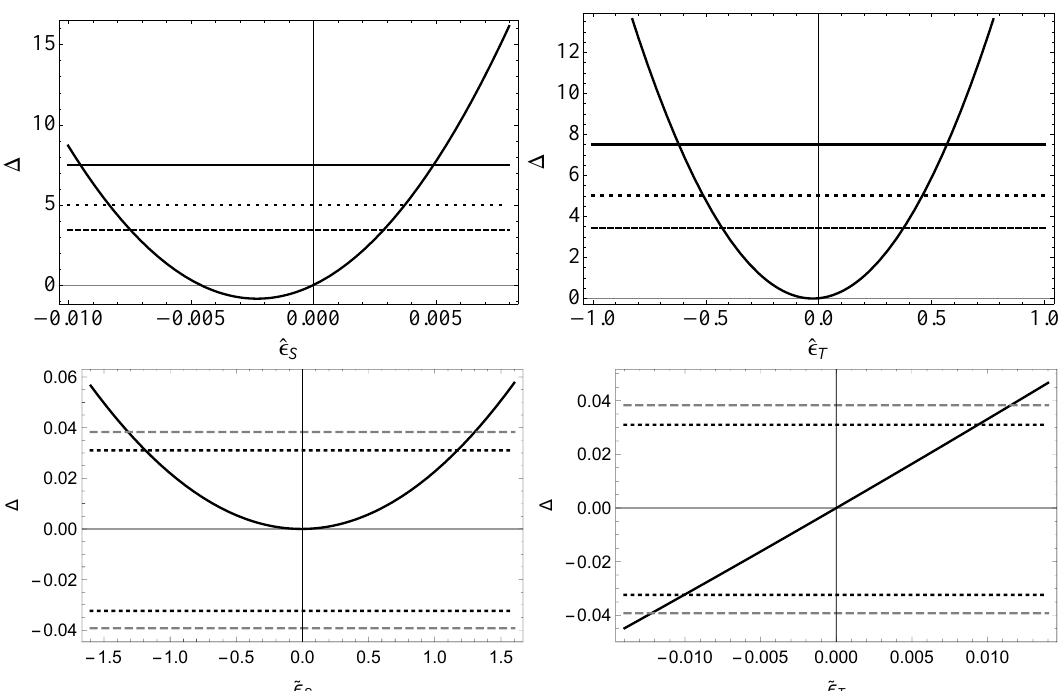
Figure 2: The parabola in the upper-half left-panel (right-panel) shows the con- ε ε = 0 obtained from τ − → π − ην straints on when τ decay (respectively, the (cid:98) (cid:98) S T ε ε = 0); the solid, dotted and dashed horizontal lines constraints [ 3 ] on when (cid:98) (cid:98) T S corresponds espectively to the upper limits obtained from CLEO [ 25 ] , BABAR [ 26 ] and BELLE [ 27 ] experiments. The solid lines in the lower-half represent the depen- dence on NS scalar (left) and tensor (right) couplings obtained from τ − → π − π 0 ν decays according to Eq. (8); the band within dashed-lines corresponds to the region allowed by the current experimental branching ratio [ 22 ] within three-standard de- viations; the hypothetical case that the error bars is reduced by a factor three (at Belle II) is shown by the band within dotted lines [ 4 ]